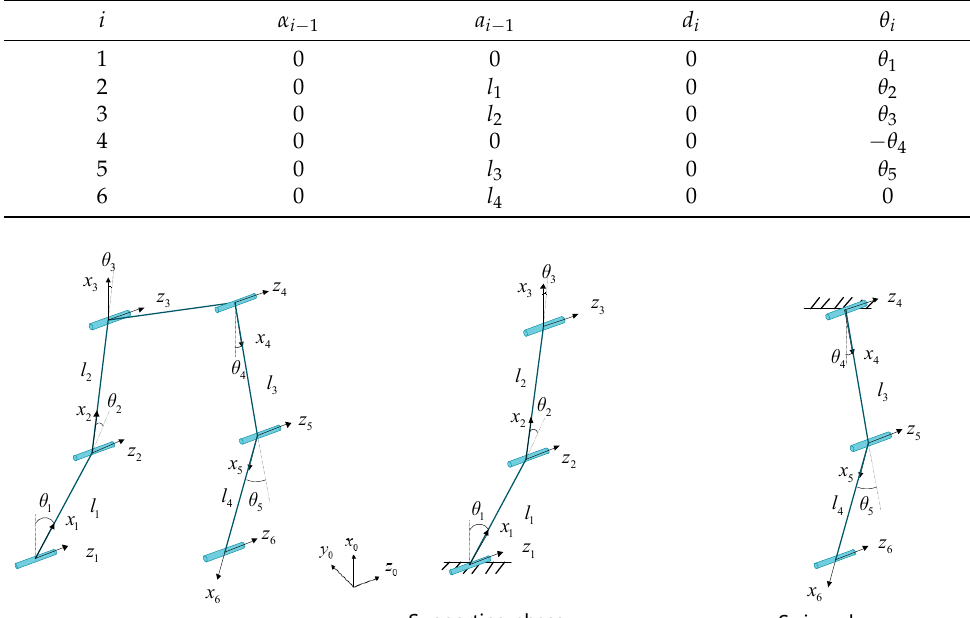
Table 2. D-H parameters.